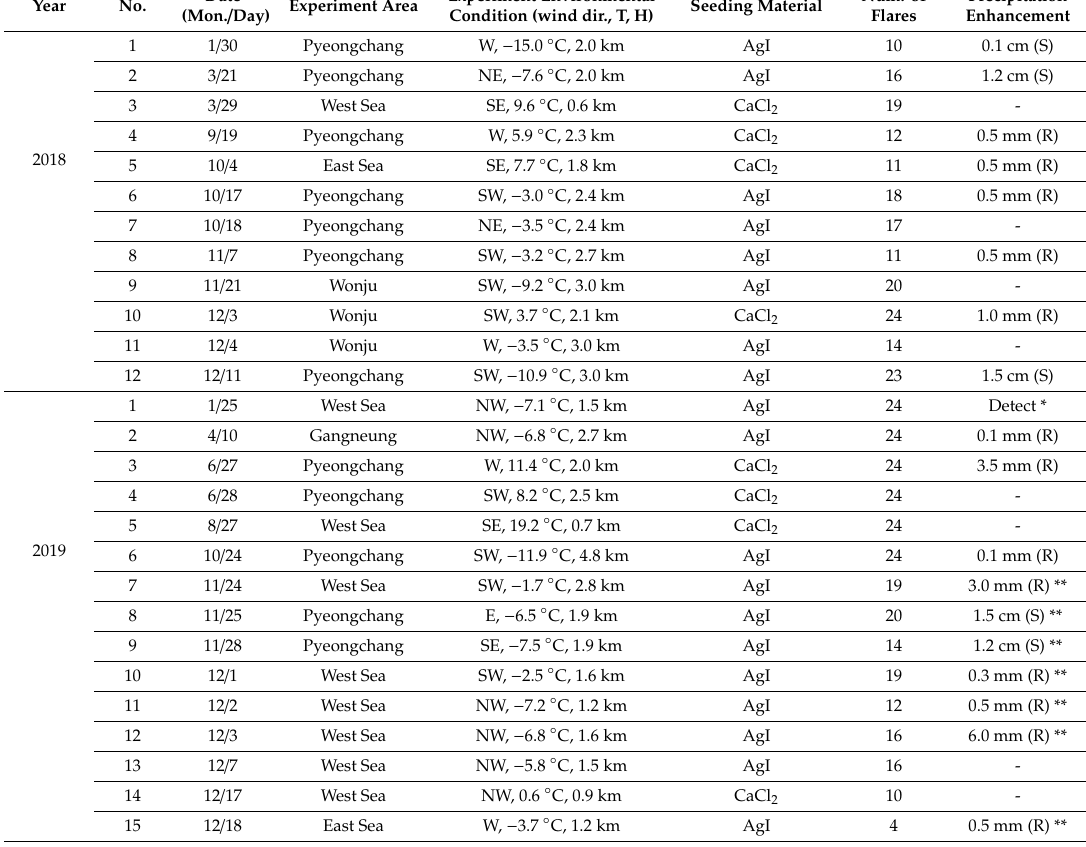
Table 2. Areas of each case of precipitation enhancement experiment in 2018 and 2019, experimental conditions (wind direction, air temperature, and experiment height), seeding material, number of flares used, and precipitation enhancement due to the seeding e ff ect (S: snowfall, R: